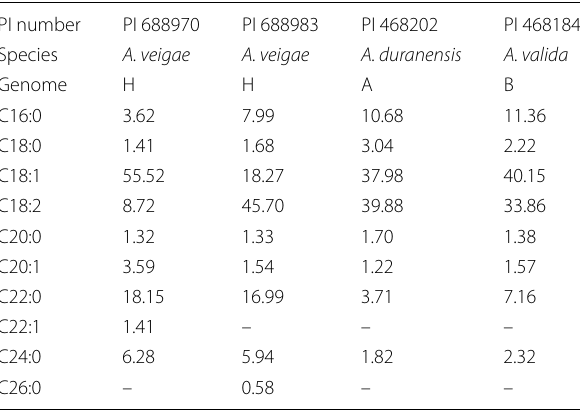
Table 1 Fatty acid composition and genome of four selected wild peanut